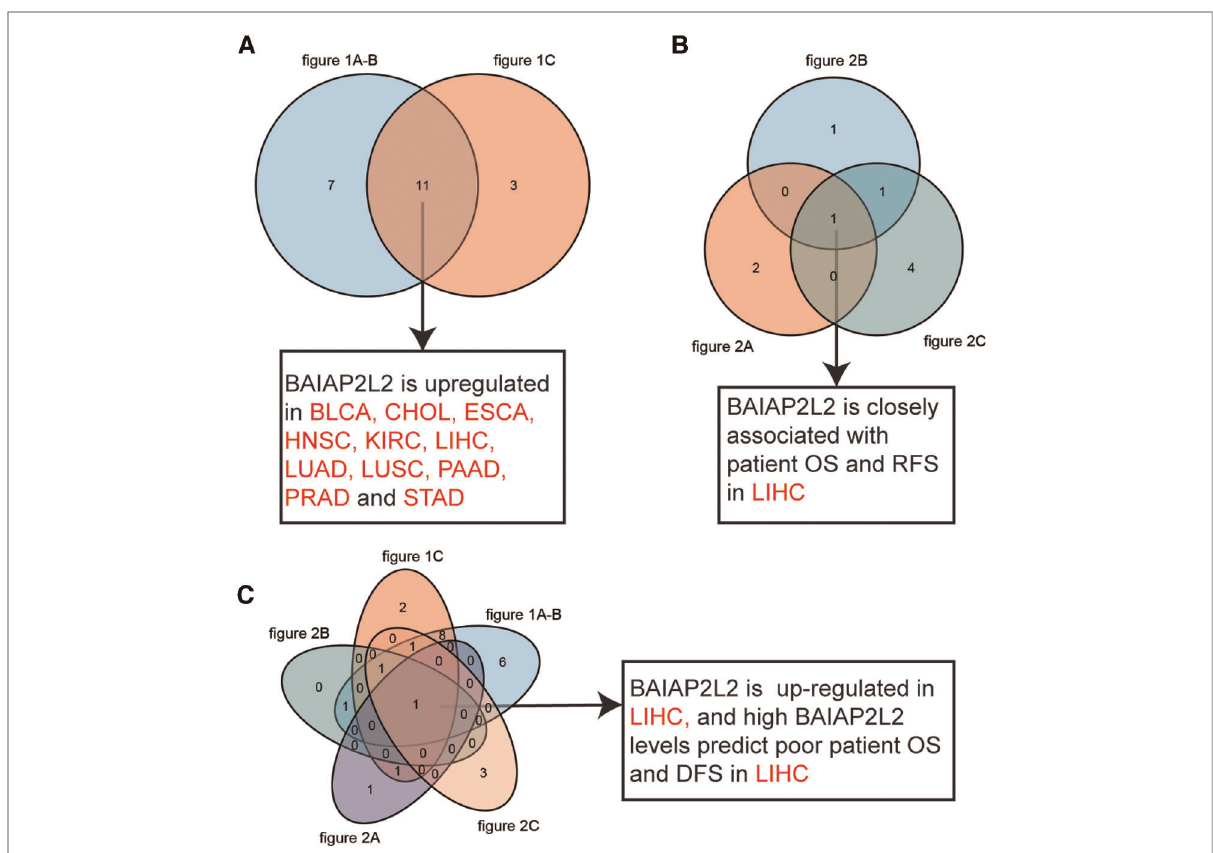
FIGURE 4 Data comparison is shown as Venn diagrams. ( A ) Comparative analysis of data in Figure 1 , BAIAP2L2 is overexpressed in BLCA, CHOL, ESCA, HNSC, KIRC, LIHC, LUAD, LUSC, PAAD, PRAD and STAD. ( B ) BAIAP2L2 is closely associated with patient OS and RFS in LIHC ( Figure 2 ). ( C ) High BAIAP2L2 levels predict poor patient OS and DFS in LIHC ( Figures 1 , 2